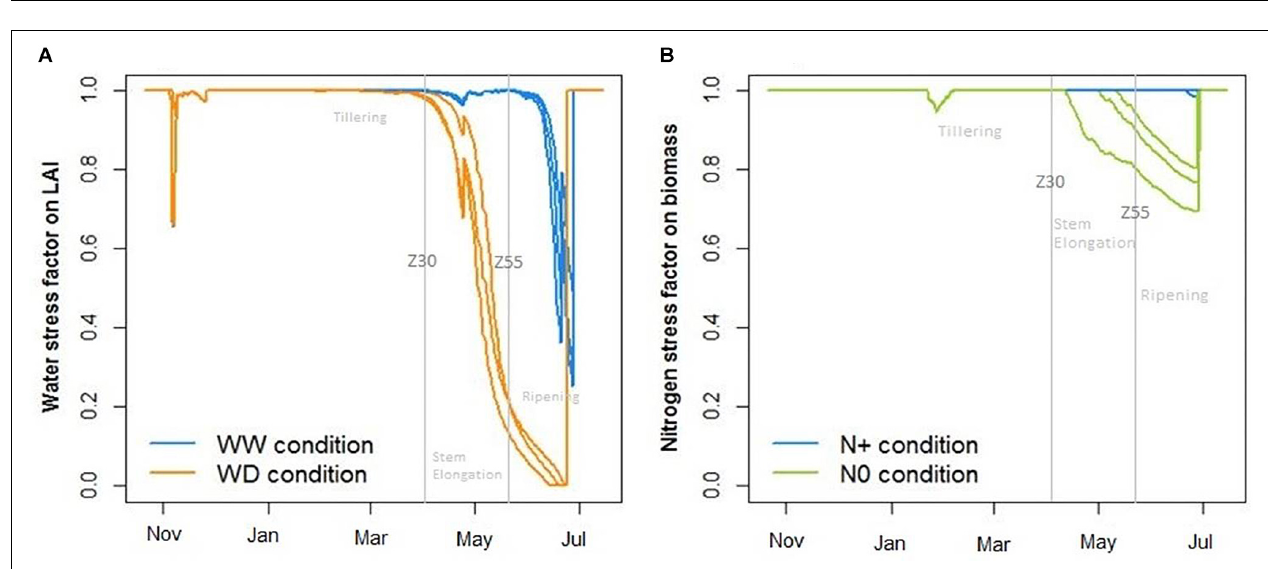
FIGURE 9 | Impact of water (A) and nitrogen (B) deficiency on, respectively, leaf area index (LAI) and total biomass where WW, well-watered conditions; WD, water-deficient conditions; N+, optimum nitrogen supply; and N0, without nitrogen supply. Stress indicators calculated with the crop model CHN.